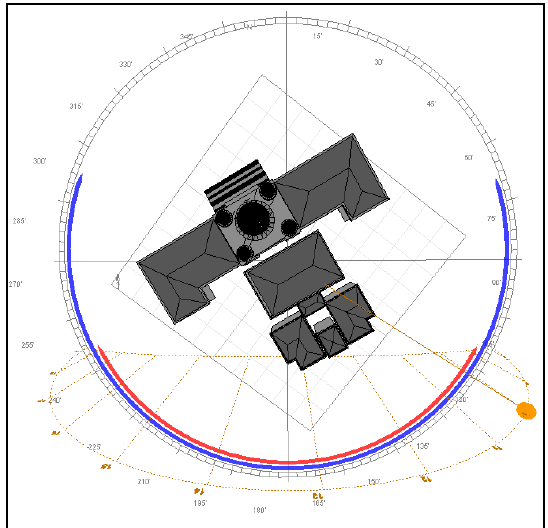
Figure 12. The position of POJ building after alteration of 37.5˚